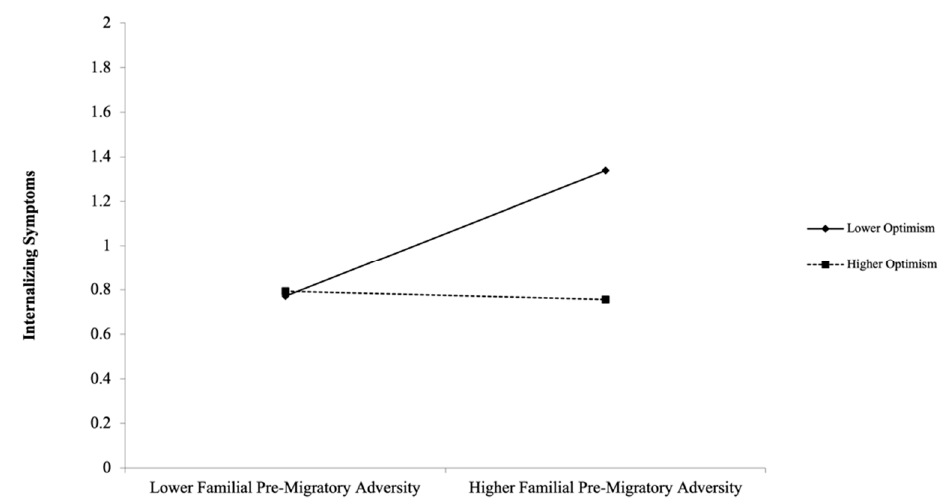
Figure 1. Interaction plot. Familial pre-migratory adversity in relation to internalizing symptoms at lower ( − SD) and higher (+1 SD) levels of optimism. The observed range of internalizing symptoms was 0.0 to 1.9.